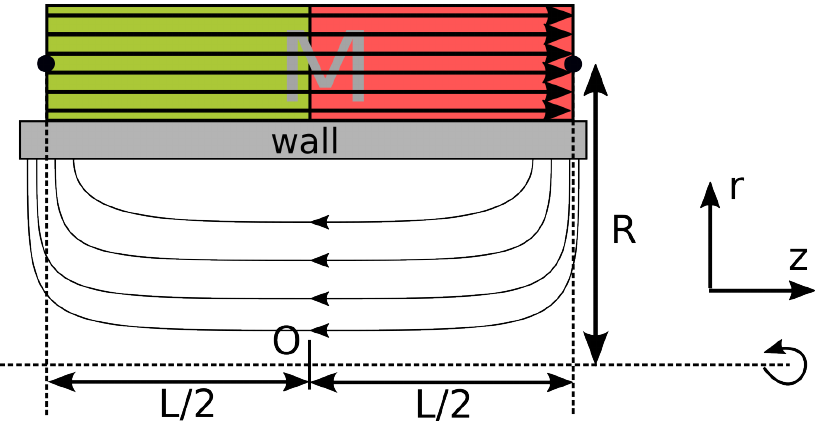
Figure 2. ( r , z )-plane of the magnetic geometry for a typical stage of a HEMP-Thruster. The center is denoted by the origin (O). The radius R and the half-length L /2 are also